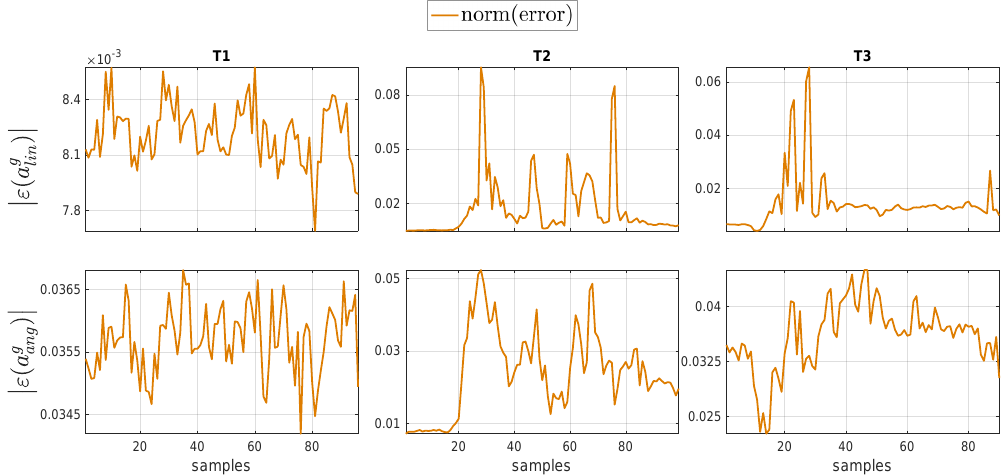
) [ m/s 2 ] and angular lin